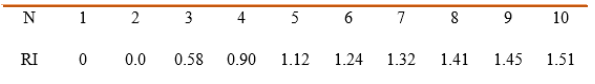
Table 3 : Determination of the random index “Eventually, calculated consistency ratio is 0.915 that is lower than the threshold 0.1, the weights’ consistency is affirmed.”